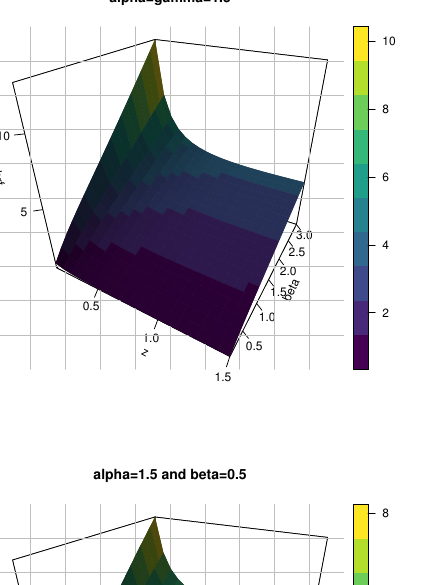
Figure 3. Plots of the pdf for the KMKE model in 3D.